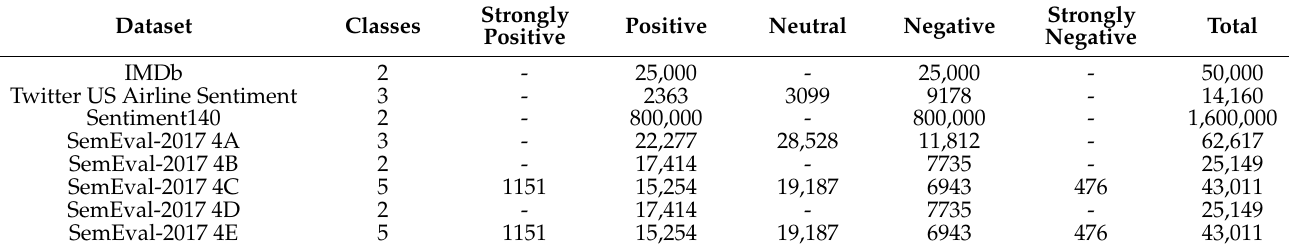
Table 4. Summary of sentiment analysis